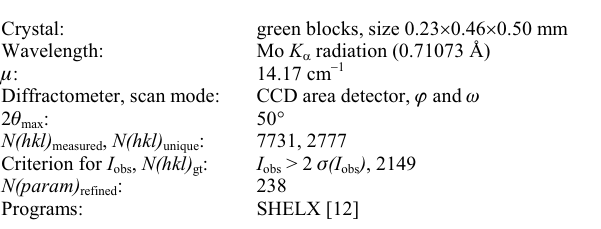
Table 1. Data collection and